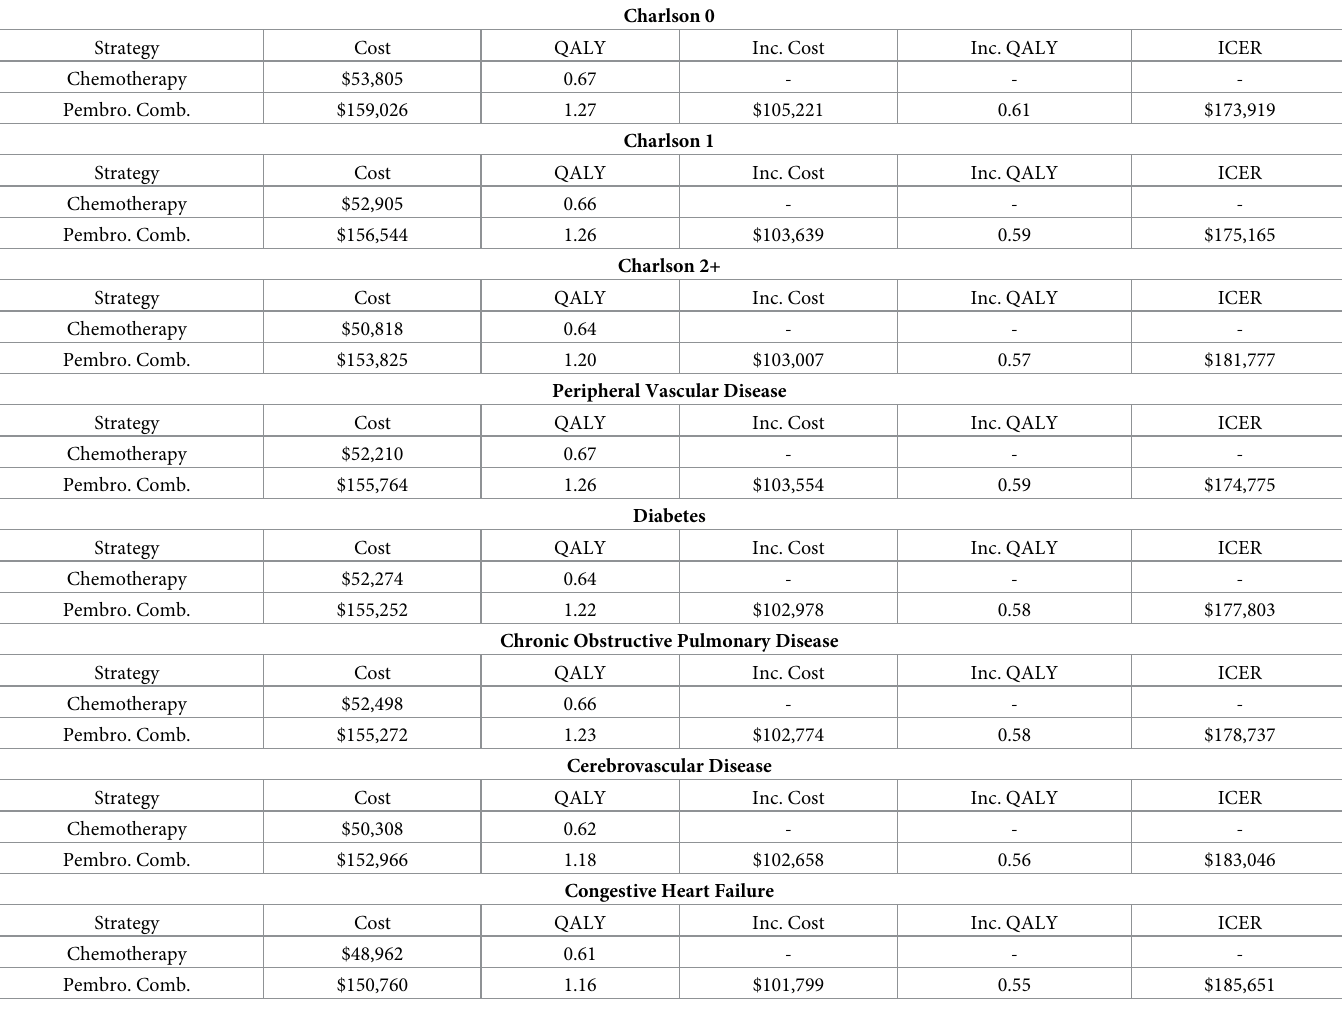
Table 2. Summary results for patients in the pembrolizumab combination therapy